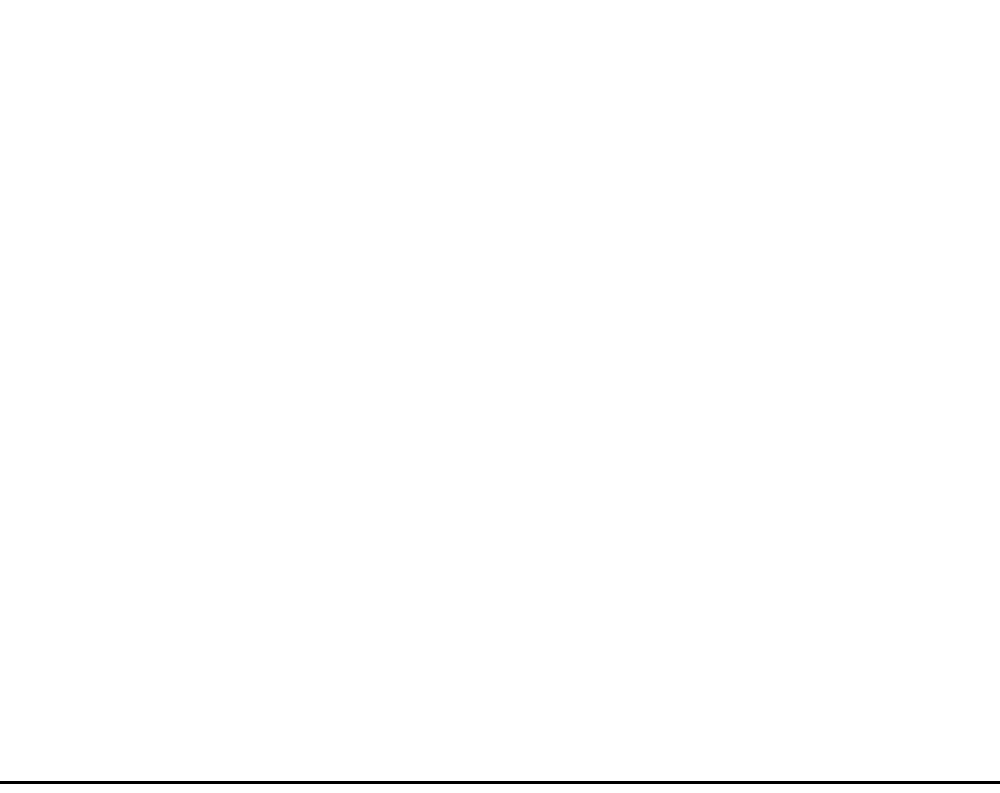
Molecular diagram of (I), showing 30% probability displacement ellipsoids. In bold, the asymmetric unit. Symmetry codes: (i) x - 1, y , z - 1; (ii) - x + 1, - y , - z + 1, (iii) - x + 1, - y , - z +